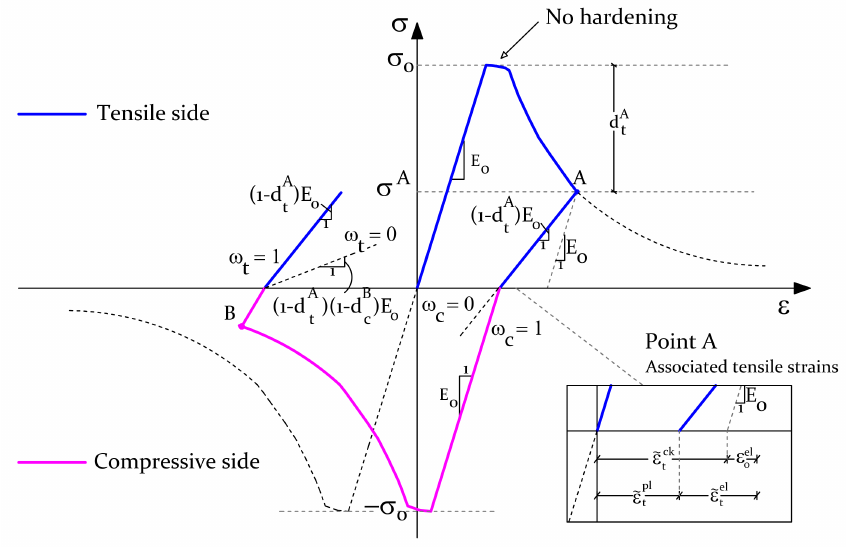
Figure 4. Hysteretic curve adopted for the out–of–plane trusses (note: for the in–plane truss beams, the tensile and compressive behaviours can have different shapes that stem from material